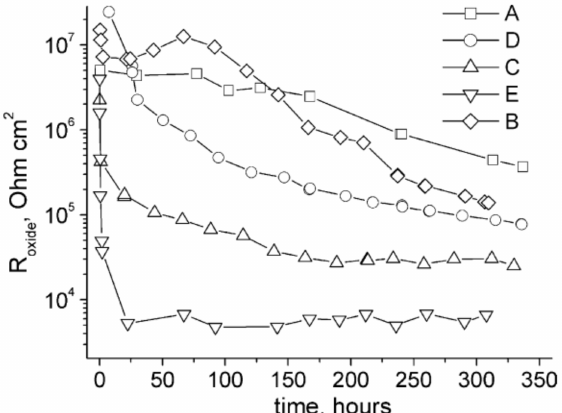
Figure 12. Evolution of the resistance of the intermediate oxide layer for the different coatings during immersion. (A—ZRO 2 nanoparticles + cerium in nanoparticles 0.5%wt, B—ZRO 2 nanoparti- cles + Cerium in the hybrid matrix, C—ZRO 2 nanoparticles + cerium in nanoparticles 1%wt, D—ZRO 2 nanoparticles, E-reference). Reproduced with permission from Zheludkevich et al., Electrochimica Acta; published by Elsevier, 2005